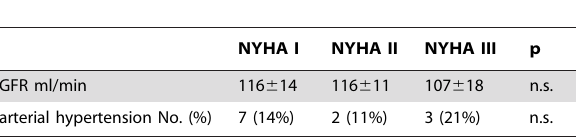
Table 3. Clinical characteristics according to NYHA